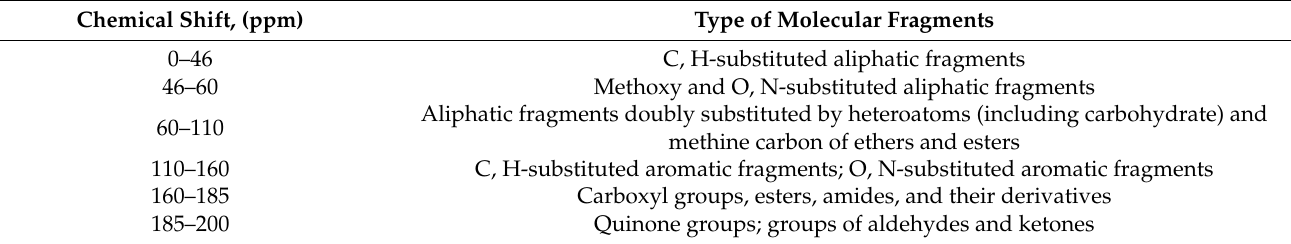
Table 1. Chemical shifts of atoms of the 13 C molecular fragments of